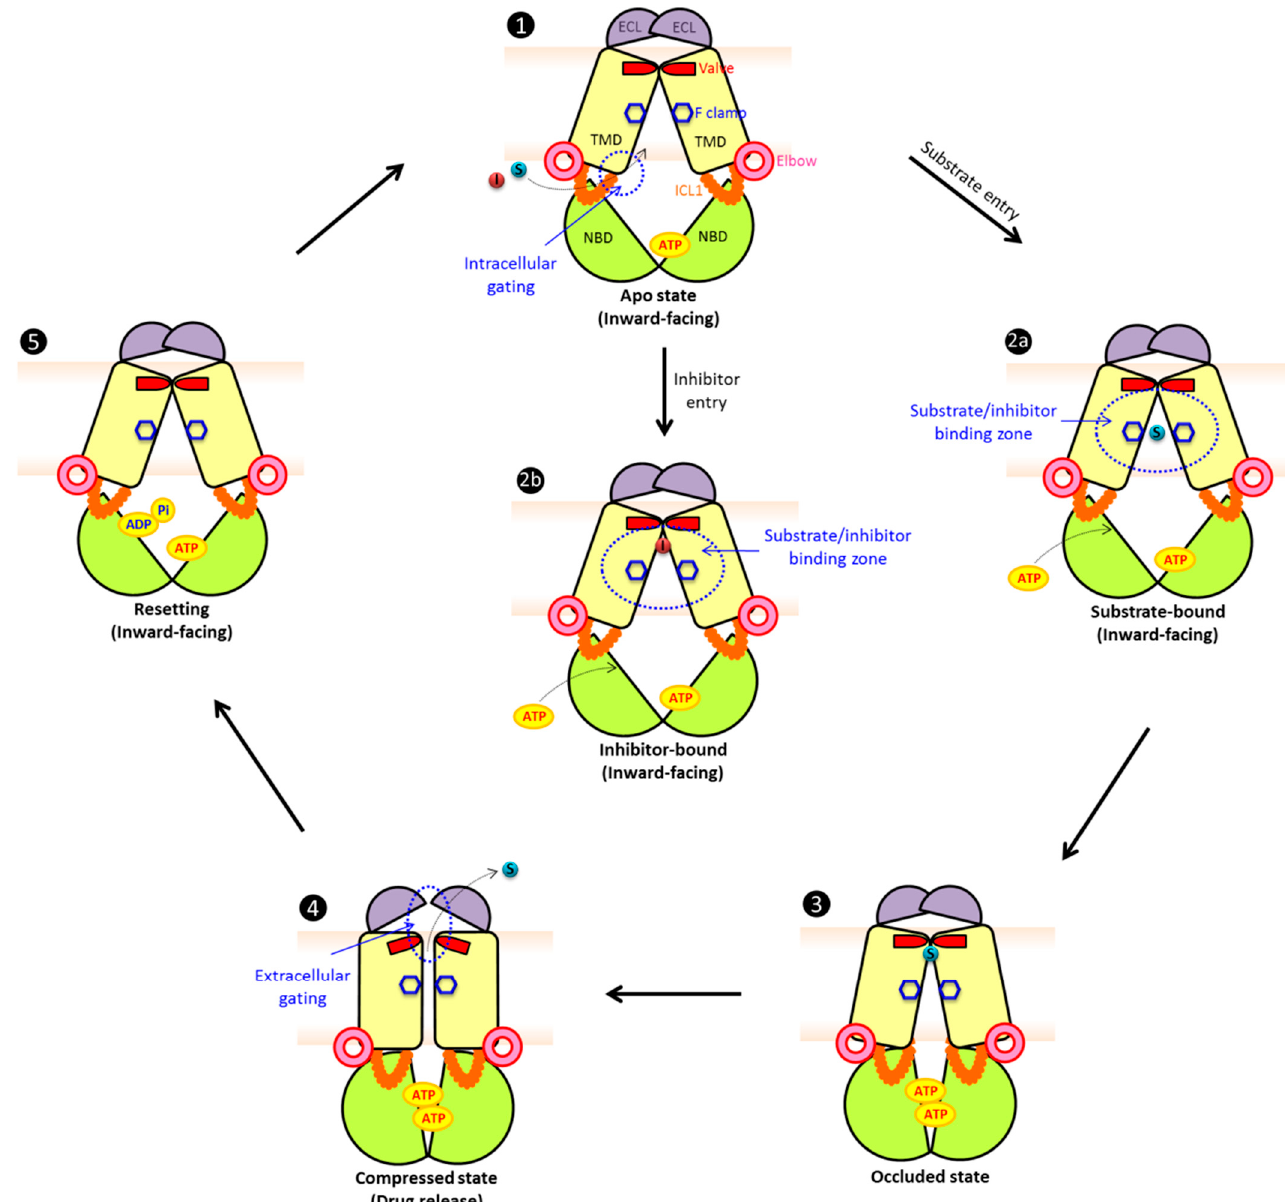
Figure 4. Proposed catalytic cycles of mammalian/fungal type II exporters (ABCG/PDR). In the apo substrate-free state ( 1 ), the exporter adopts an inward-facing conformation. We propose that NBDs are open with ATP present in at least one NBD or both, which mediates partial NBD dimerization leaving only one accessible ATP-binding region. The intracellular gate(s) at the transmission interface provides access for substrate or inhibitor entry. The aromatic rings at the conserved F clamp form accessible binding sites at the closed transporter valve subtending the closed ECL. Drug substrates ( 2a ) or inhibitors ( 2b ) can enter through intracellular gate(s), preceding their trapping in distinct binding zones in the central cavity. Binding of ATP at the second binding site or both triggers full NBD dimerization and triggers a first conformational change, setting an occluded state ( 3 ). The communication between NBD and TMD is regulated via a rigid triple helical bundle (THB) as a key part of the transmission interface. The NBD dimerization compresses the central cavity space to drive substrate movement through the translocation, thus engaging a push and squeeze motion to open the valve. Substrates shift into the upper cavity and are released by the subsequent opening of the ECL lid ( 4 ). ATP hydrolysis at one NBD site may be enough to reset the catalytic cycle and to convert the transporter molecule into the inward-facing drug-recognizing state ( 5 ). The structures show NBDs (green), elbow helix (pink), TMDs (yellow), ICL (orange), ECL (purple), phenylalanine clamp (blue hexagon), valve (red), substrates (cyan) and inhibitors (red). For more details and references see the main text.